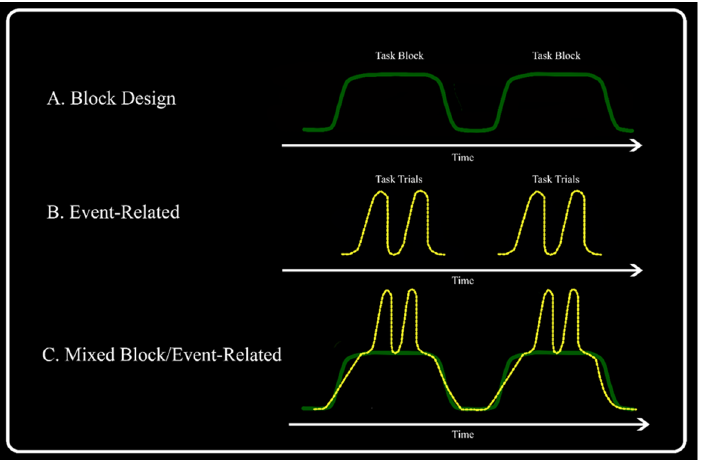
Figure 1. Contrasting experimental fMRI designs distinguish between various tasks-related signals: ( A ) the solid, green line represents the block design, wherein the task block represents a prolonged period of a repetitive paradigm separated by rest; ( B ) the dashed, yellow line represents the event- related task trials that exhibit different conditions presented in a random sequence; ( C ) mixed-type design with transient activities (trials) presented throughout the sustained activity (task